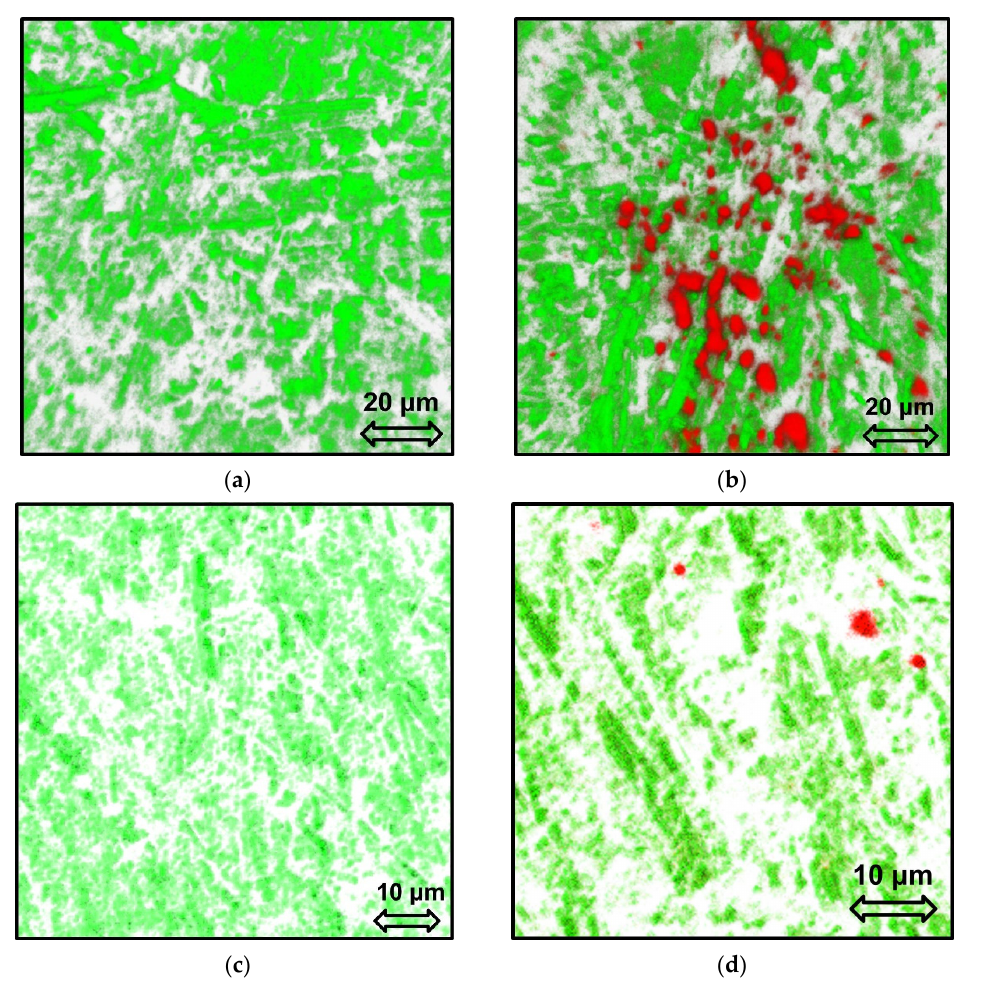
Figure 8. CLSM images of 3D reconstructed surface of aptasensor (Au disc/LC-18) with a dense ( a , b ) and a sparse ( c , d ) aptamer layer before ( a , c ) and after ( b , d ) contact with blood plasma from a lung cancer patient ( b ) and a healthy candidate ( d ). Green for the aptamer, red for proteins from blood plasma.